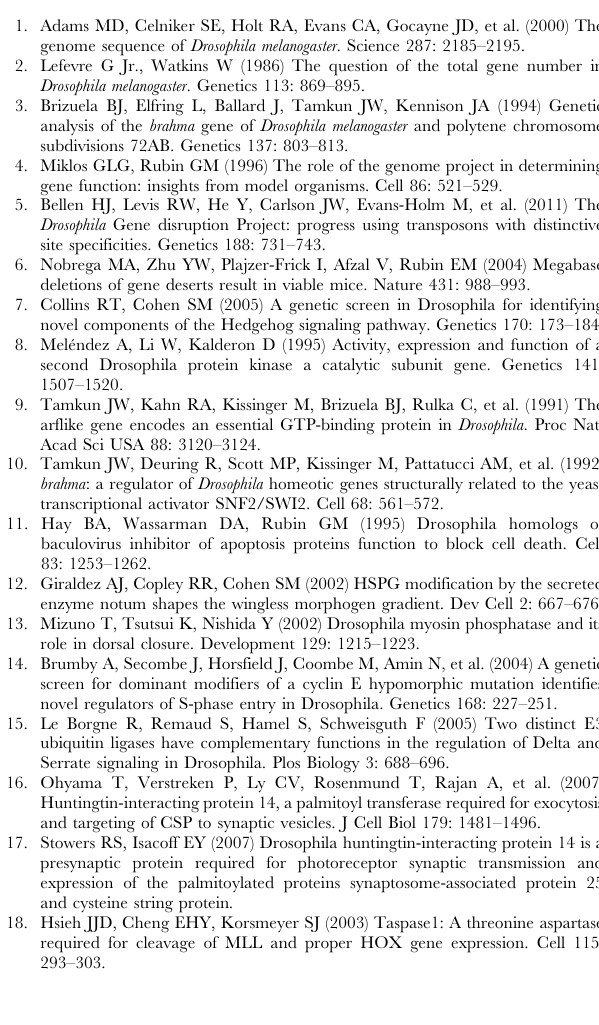
Table S1 Sequences (12 base pairs or longer) from the 72D region that are conserved among Drosophila